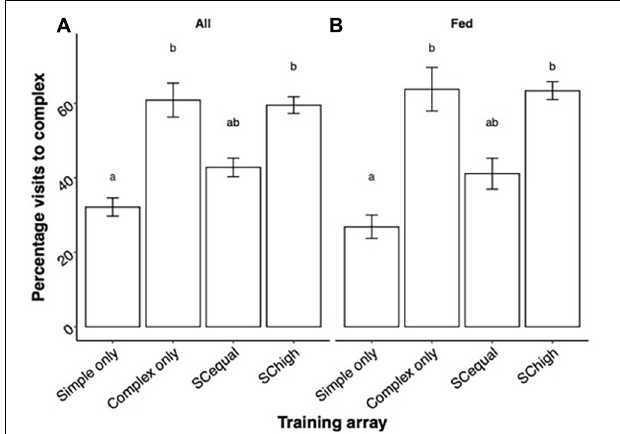
FIGURE 2 | Mean ± SE percent of test-phase visits in complex flowers. (A) Both successful and unsuccessful visits, (B) only successful (fed) visits. Different letters indicate significant differences in Tukey post hoc tests, which are detailed in Supplementary Table 2 .